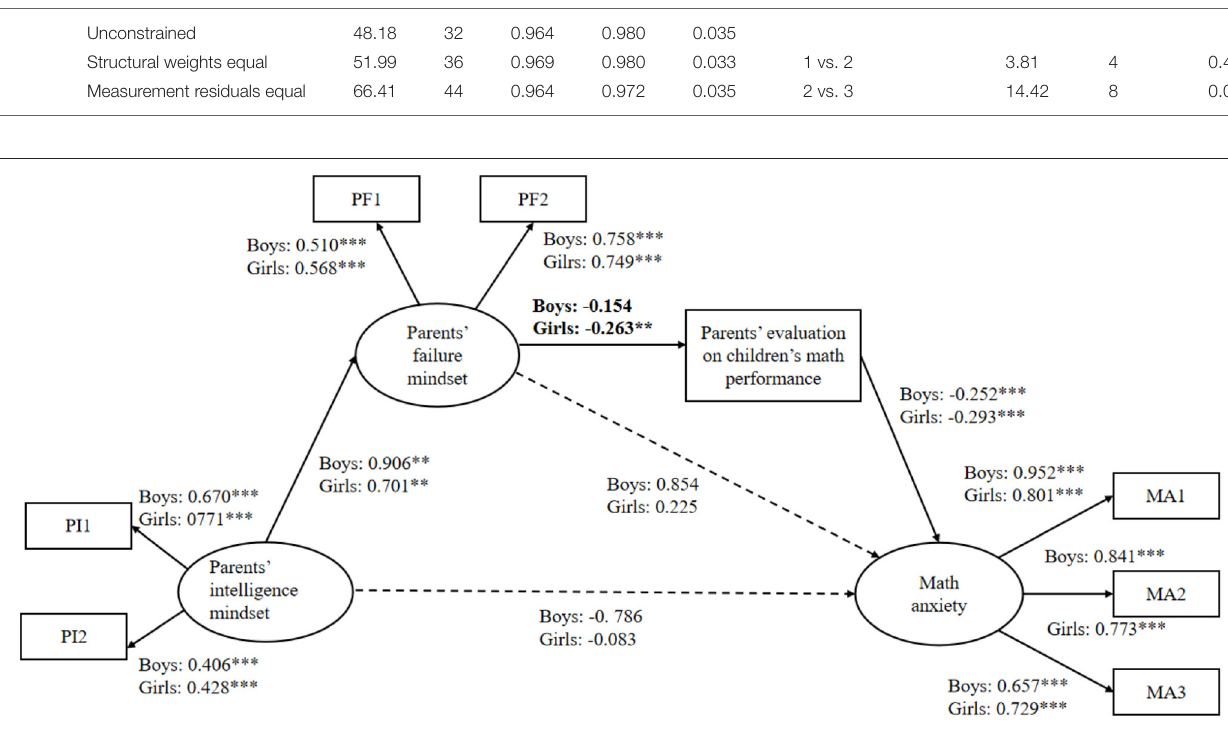
of their child’s math performance, and students’ math